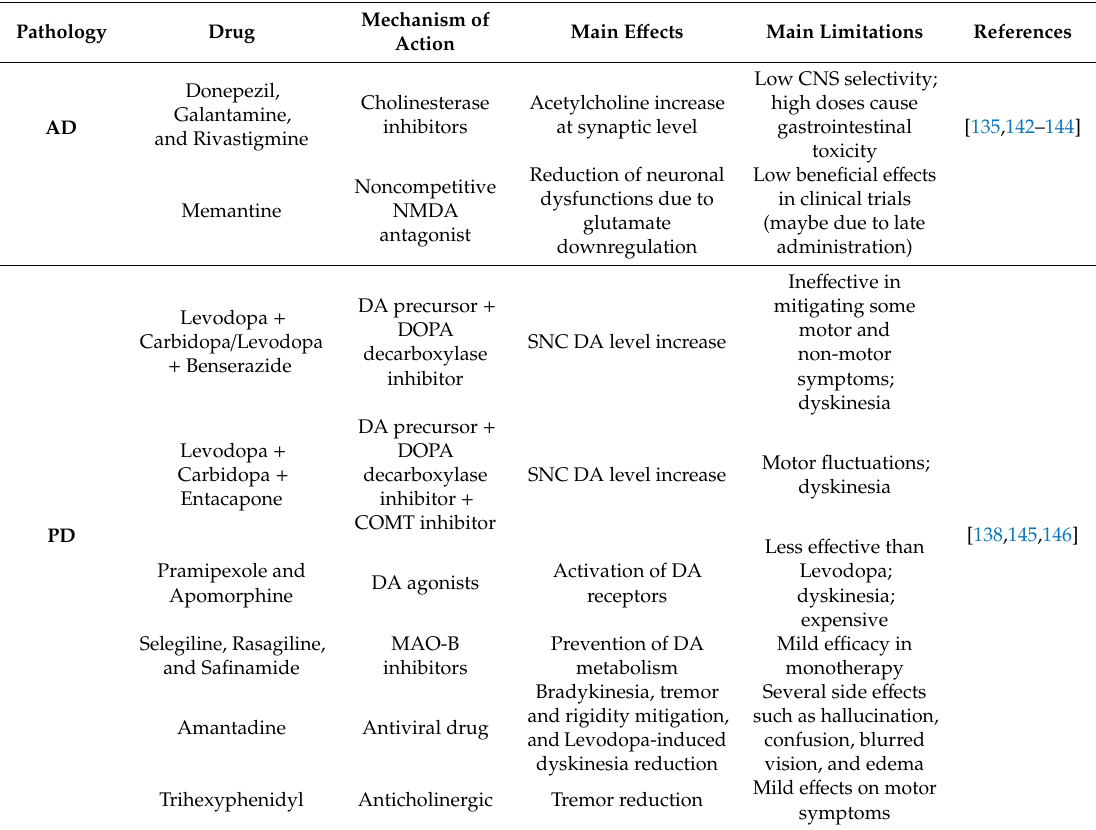
Table 1. Available treatments for Alzheimer’s disease (AD), Parkinson’s disease (PD), Huntington’s disease (HD), Amyotrophic Lateral Sclerosis (ALS), and Spinal Muscular Atrophy (SMA). The table summarizes the most common therapies for these neurodegenerative pathologies. Unfortunately, the majority of these treatments are only symptomatic or palliative and cannot stop the disease progression (especially for AD, PD, HD, and ALS) or are less e ff ective in milder and late treated patients (as in the case of